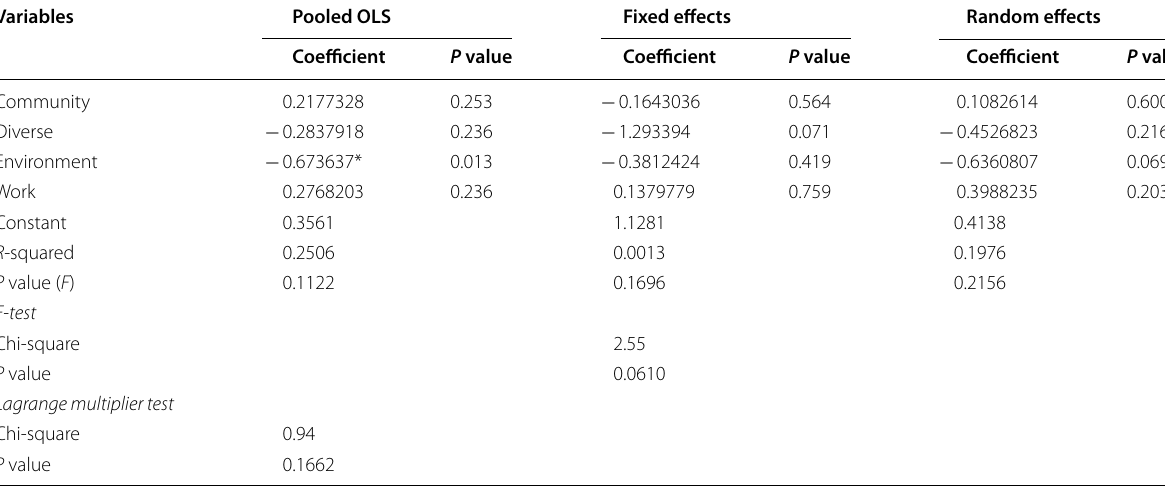
The result is evaluated based on a 95% level of significance